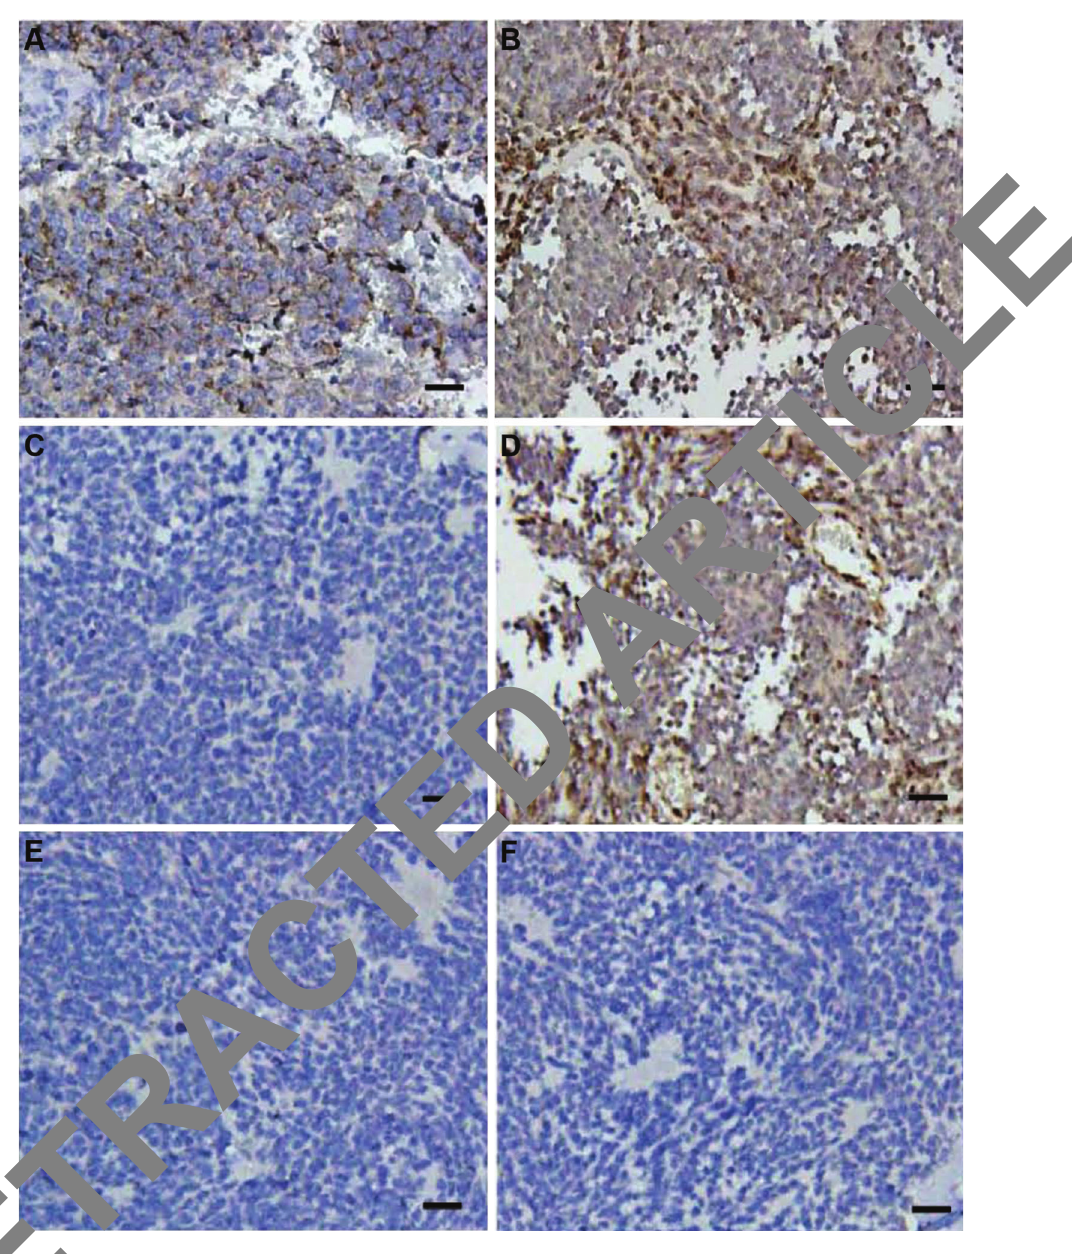
Supplementary Figure S1 - Immunohistochemical analyses of YAP and GAB1 to identify medulloblastoma subtypes. (A, B) The SHH subtype was positive for both (A) YAP1 and (B) GAB1. (C, D) The WNTsubtype was positive for (C) YAP1 and negative for (D) GAB1. (E, F) The non-SHH/WNT subtype was negative for both YAP1 and GAB1. Magnification, 400 (cid:1) ; scale bar, 50 m m. non-SHH/WNT subtypes. As shown in Table 1, 20% of the tumors (n=8) were the WNT subtype, and 32.5% (n=13) were the SHH subtype. The remaining 47.5% of patients (n=19) presented with the non-SHH/WNT subtype of medullo- blastoma.